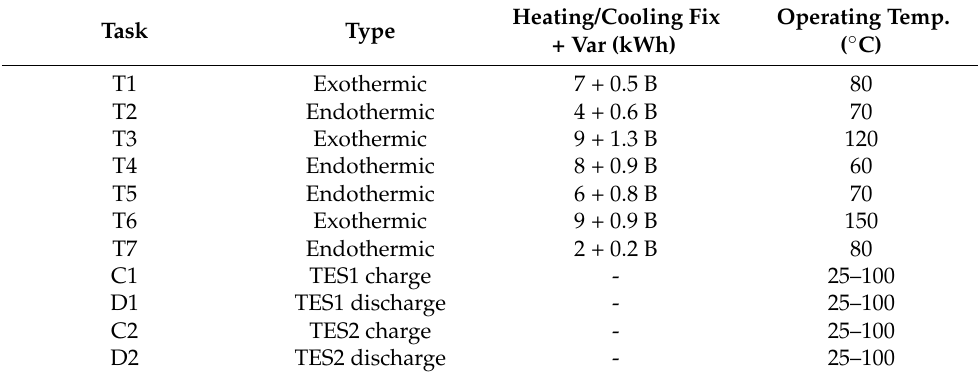
Table 7. Energy requirements and characteristics of Example II.